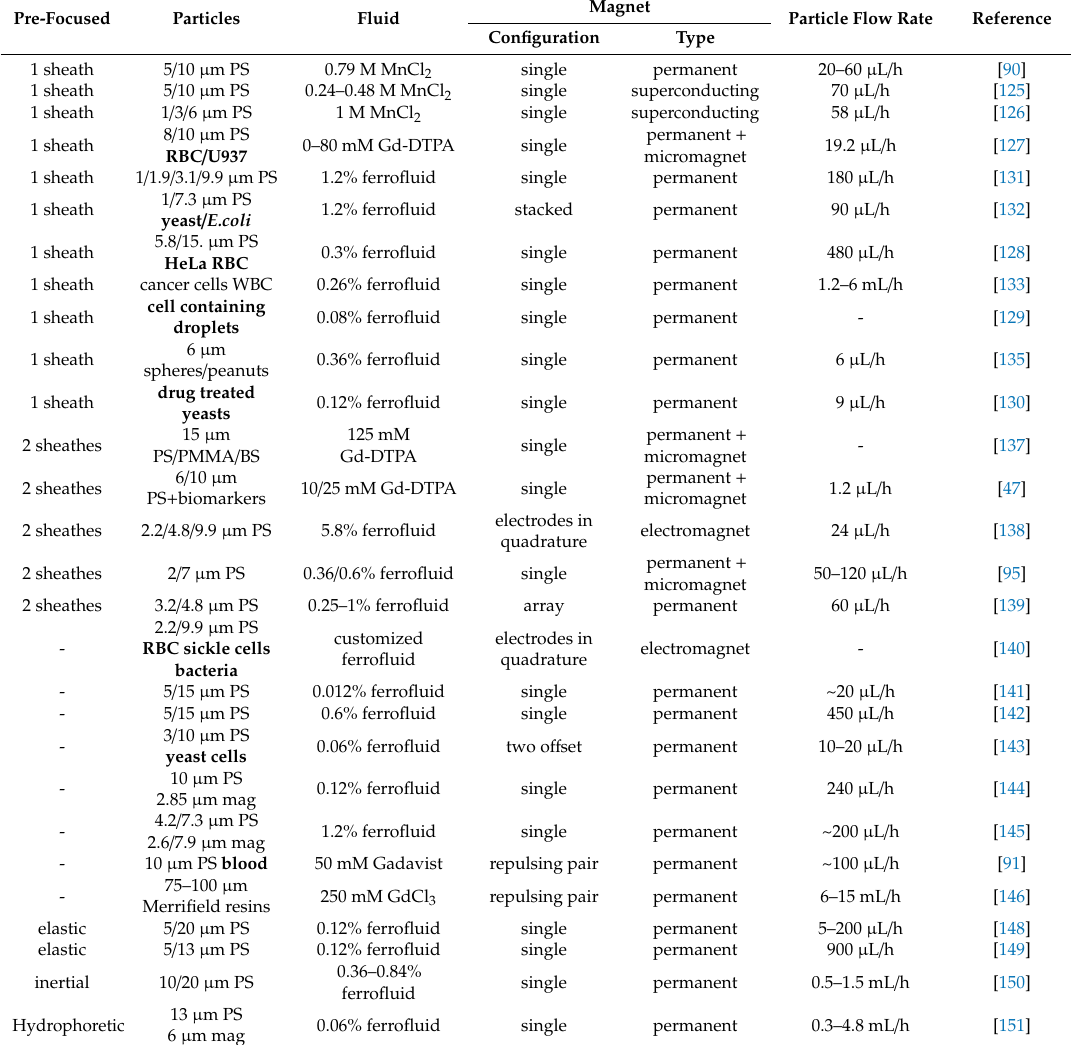
Table 4. Summary of the published papers on diamagnetic particle separation in magnetic fluid flows. Note that the use of biological cells in the separation demonstration has been each highlighted in bold